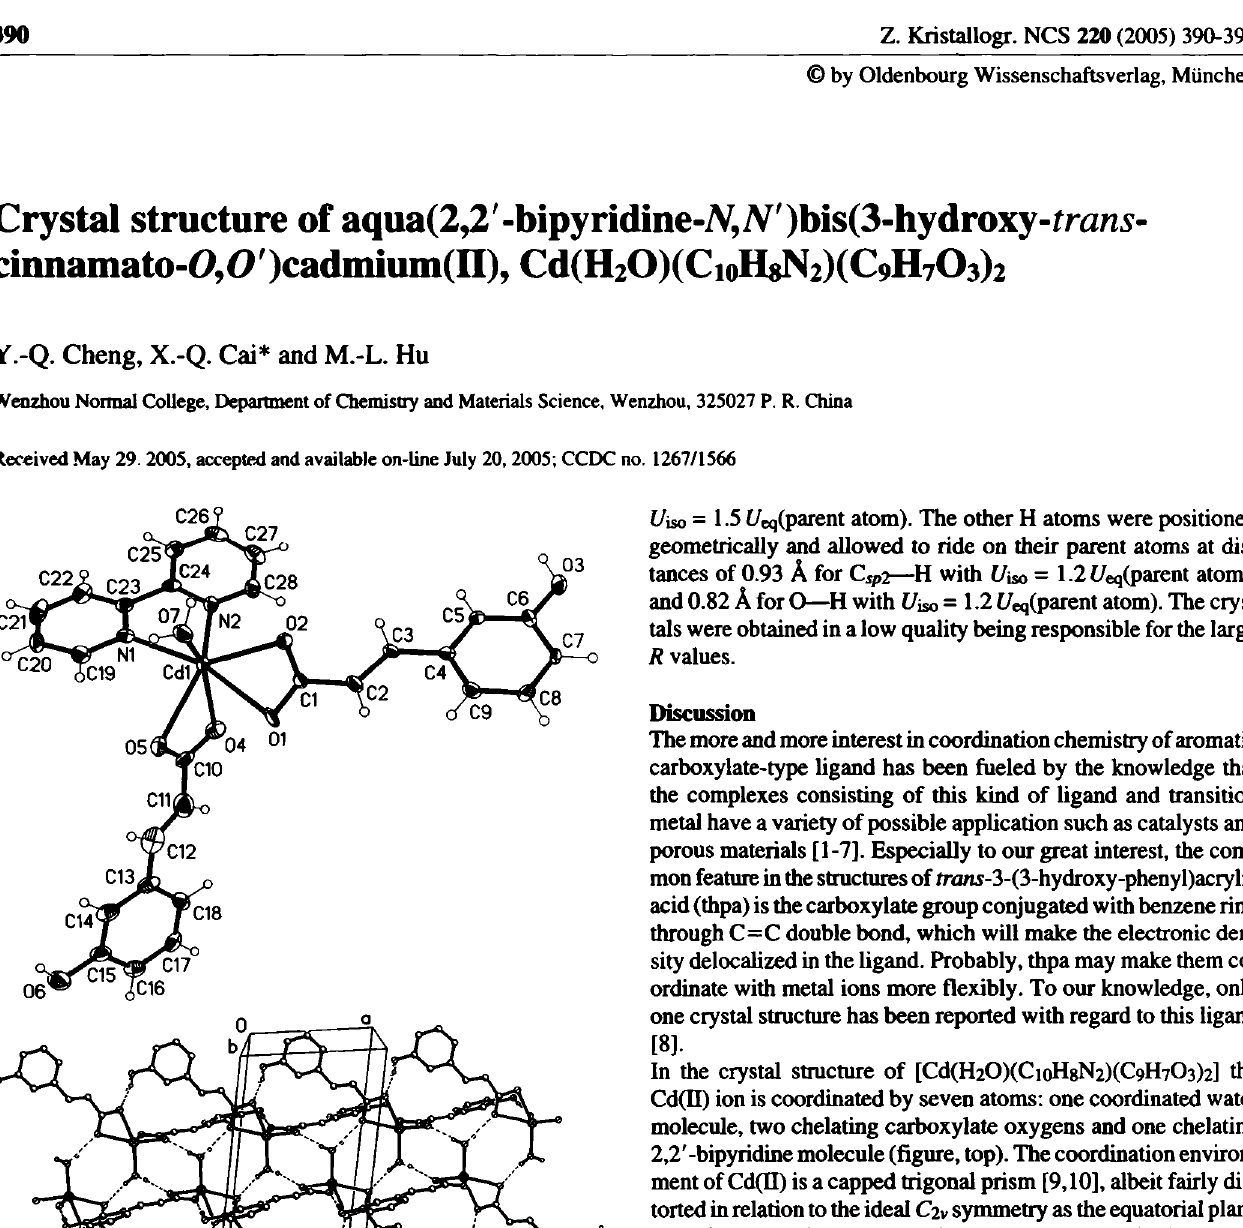
Table 1. Data collection and handling.